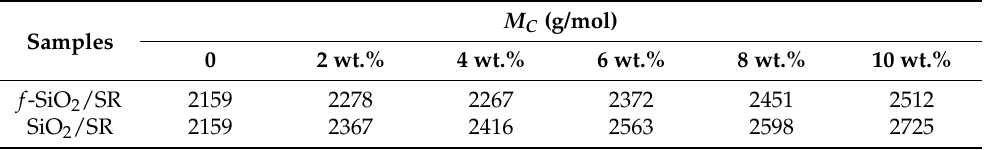
Table 4. Comparison of M C for SiO 2 /SR and f-SiO 2 /SR composites.